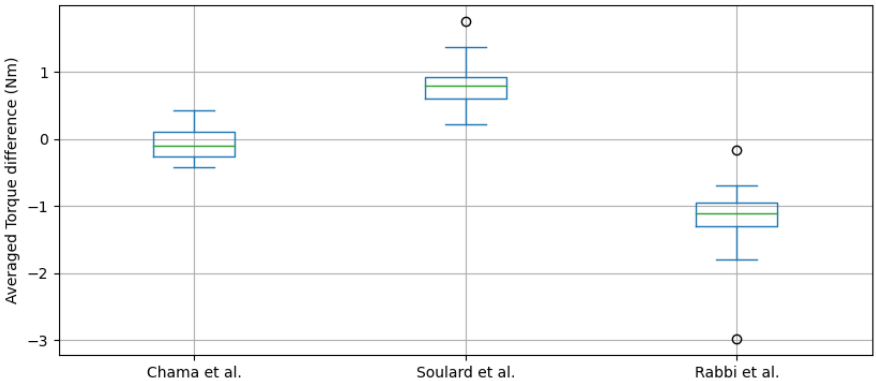
Figure 11. Box plot of average torque difference of various (Rabbi et al. [8], Chama et al. [9], Soulard et al. [19]) analytical T c equations from target T c for the region 0.5 > s ≥ 0 for the design